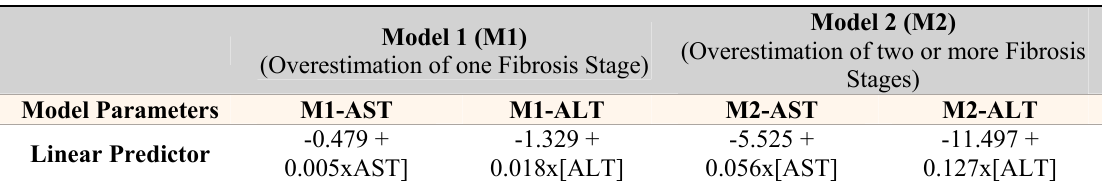
Figure 1. Probability Plot of Models 1. The two figures represent the probability of overestimation of one fibrosis stage by liver elastography measurement according to serum ALT (left) and serum AST (right). Logistic regression coefficients of probability are represented with 95% confidence intervals (light gray area). Table 4. Association between serum transaminase and liver fibrosis overestimation. Models were realized according to fibrosis measurement one-year after SVR12. VIF: variance inflation factor; AIC: Aikake information criterion; BIC: Bayesian information criterion; AUROC: area under the receiver- operating characteristic